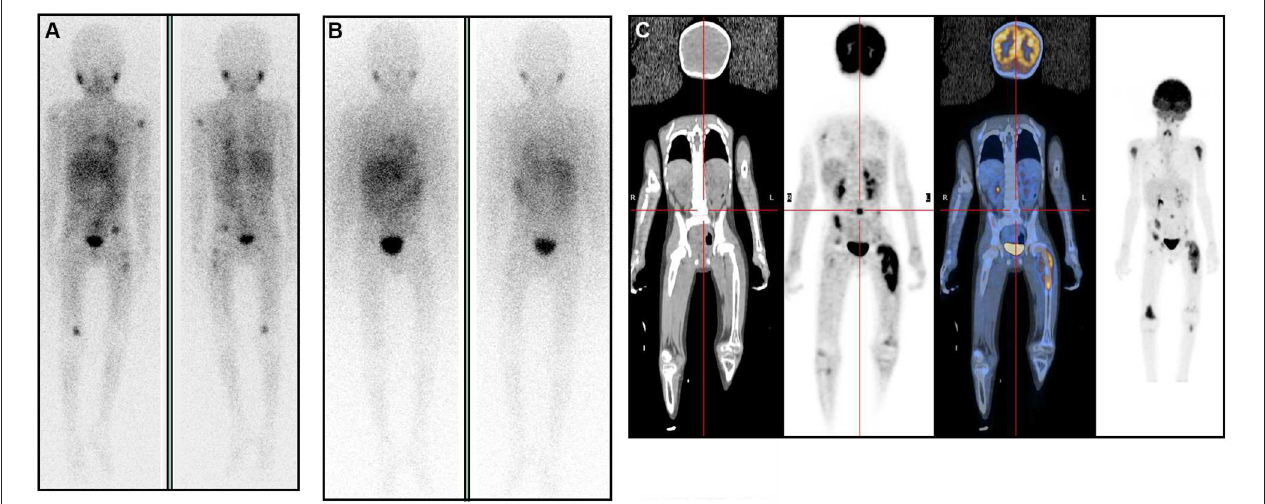
FIGURE 1 | False complete response after 131-I-mIBG therapy: (A,B) 123-I-mIBG scans. (C) 18-F-FDG-PET-CT scan. (A) positive scan previous to 131-I-mIBG therapy, with multiple spots. (B) negative post-mIBG therapy scan (Complete Response). (C) as response was much better than expected, a post-therapy PET-CT scan was requested, showing non-mIBG-avid Progressive